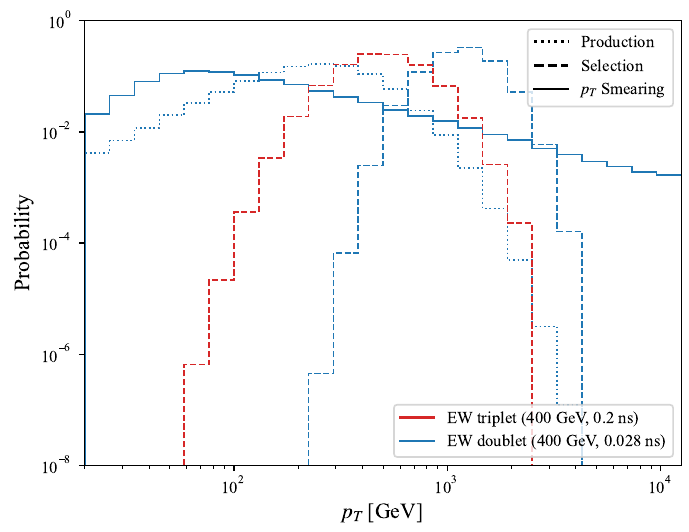
Figure 3 . Unit-normalized p T distributions for a 400-GeV chargino from an EW triplet (red lines) and doublet (blue lines), with proper lifetimes τ = 0 . 2 ns and 0 . 028 ns, corresponding χ ± to the pure wino and pure higgsino scenarios, respectively. The spectra are shown at generator level (dotted lines), after event and tracklet selection (dashed lines) and after smearing (solid lines). Note the doublet and triplet distributions are indistinguishable at production, confirming that event kinematics are dependent only on the mass of the state, and not its EW quantum numbers. The significant difference in the chargino lifetimes are evident in the distributions after selection, with the shorter-lived doublet requiring a larger transverse boost in order to satisfy the 4-hit requirement on tracklets. However these differences are obscured once resolution effects due to imperfect tracklet reconstruction are taken into account, and are not fully exploited in the analysis.